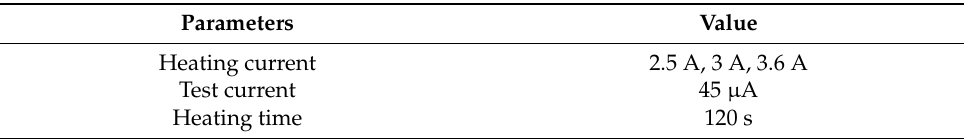
Table 3. Test conditions of V